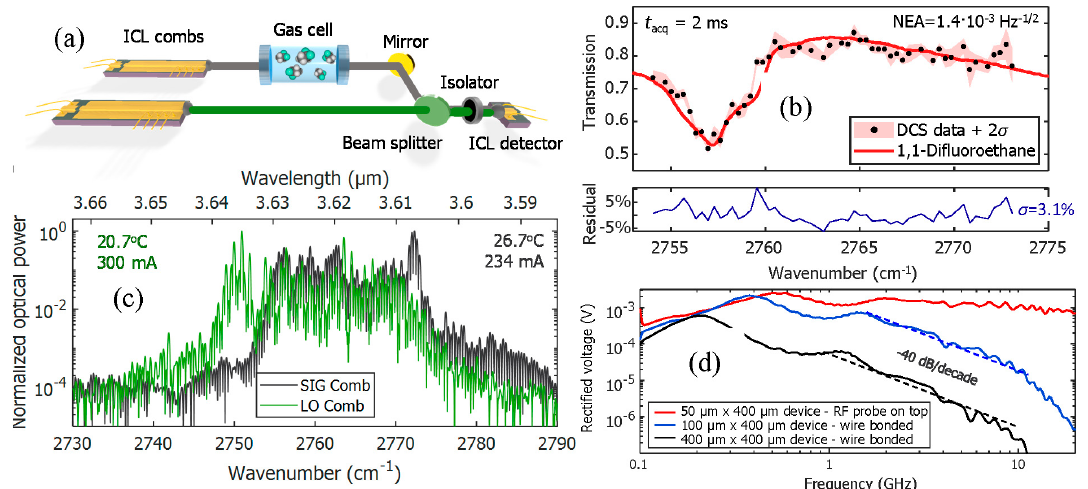
Figure 18. Dual comb spectroscopy with two ICL combs: ( a ) Schematic of the experimental setup; ( b ) superimposed emission spectra of the two ICL combs; ( c ) experimental (points) and simulated (curve) dual-comb spectrum of 1,1-difluoroethane at atmospheric pressure; ( d ) frequency response of ICDs with three different lateral dimensions from microwave rectification characterization. Reproduced from Ref. [164], with the permission of AIP Publishing.